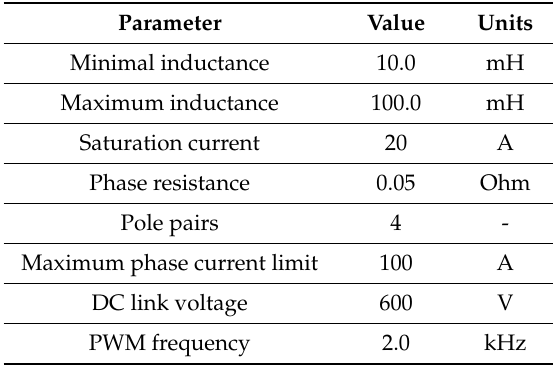
Table 1. Switched reluctance drive (SRD)